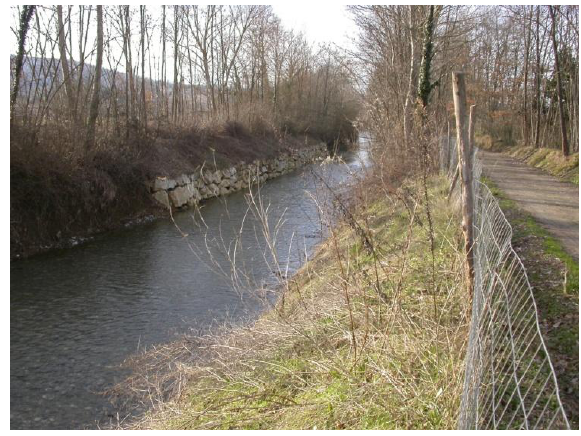
Figure 17. Artificial embankment